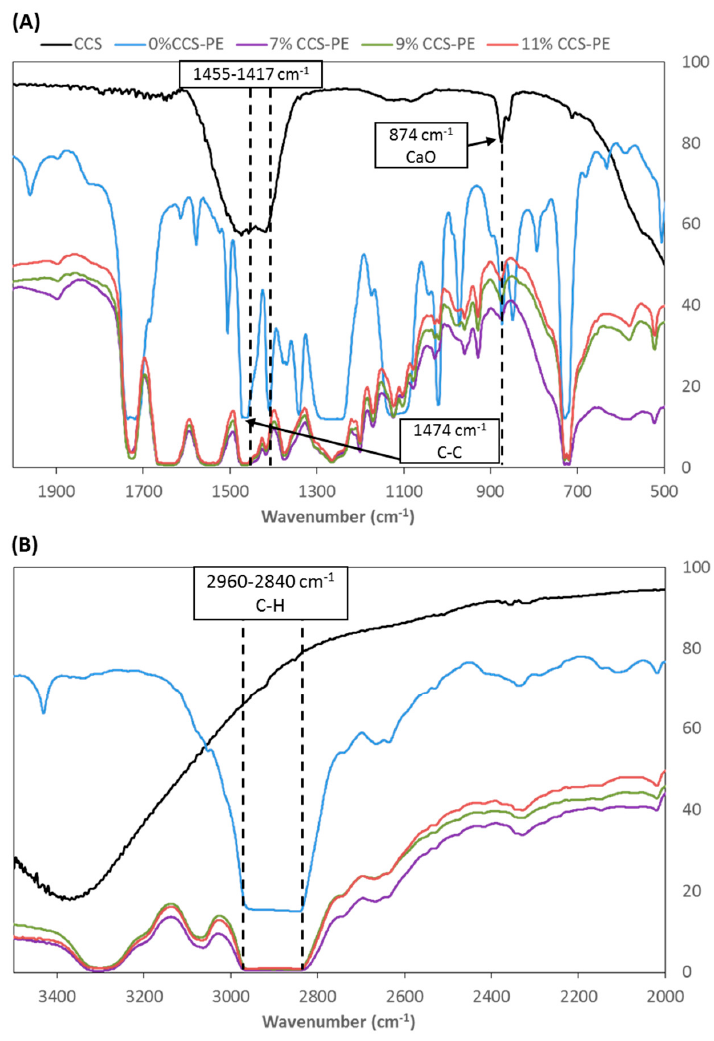
Figure 3. Fourier transform infrared (FTIR) spectra of CCS powder, 0%, 7%, 9%, and 11% CCS-PE